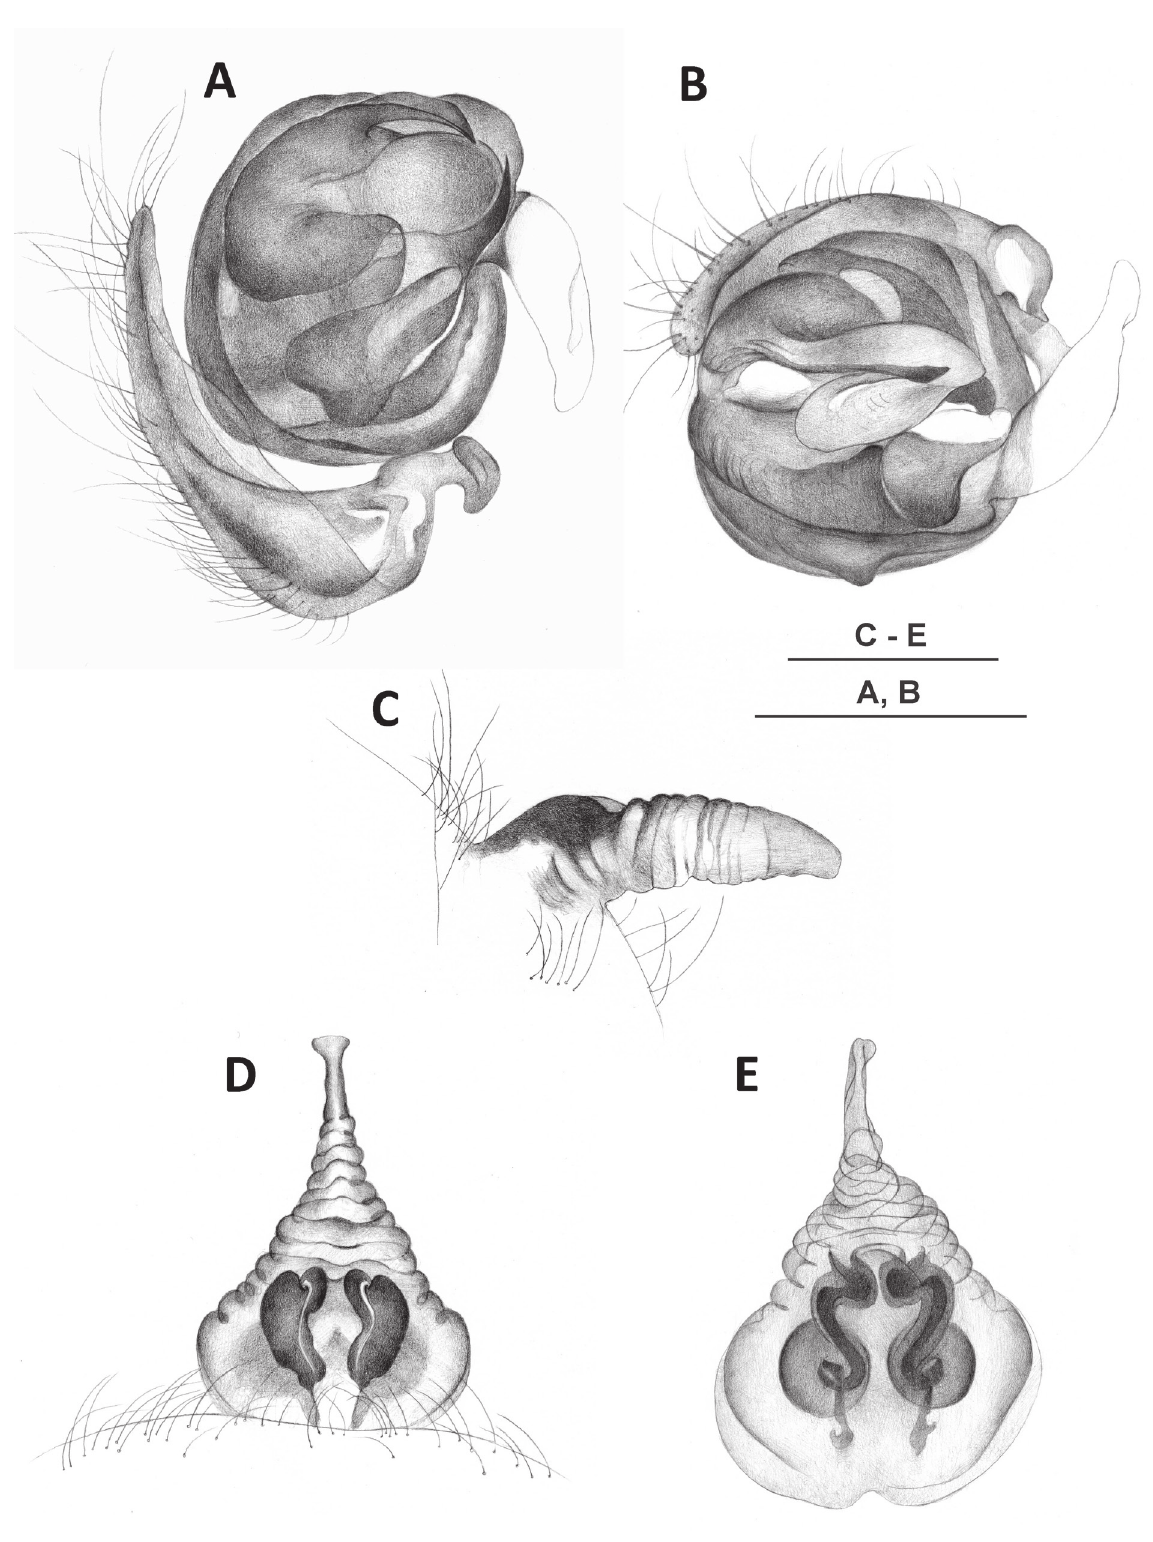
Fig. 3. Eustala orientalis sp. nov. A . ♂ left palp, ventral view. B . ♂ left palp, apical view. C . ♀ scapus, lateral view. D . ♀ epigyne scapus, ventral view. E . ♀, spermathecae. Scale lines = 0.5